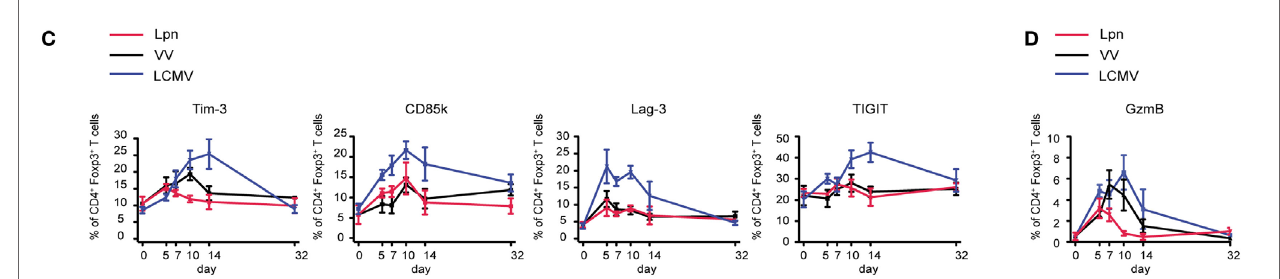
FigUre 4 | Expression of co-inhibitory receptors and granzymes is a mutual feature of Th1-driven Treg specialization. C57BL/6 mice were acutely infected with LCMV WE (blue), Legionella pneumophila (Lpn, red), Vaccinia Virus (VV, black), C. albicans (yellow), or left naïve and expression of the co-inhibitory receptors Tim-3, CD85k, Lag-3, and TIGIT (a,c) , or granzyme B (B,D) among live CD4 + Foxp3 + Treg cells was determined by flow cytometry. (a,B) Peak expression levels of (a) TIGIT, CD85k, Lag-3, Tim-3, and (B) granzyme B among splenic CD4 + Foxp3 + Treg cells (Lpn: day 5–7; VV: day 7–10; LCMV: day 10–14) or among CD4 + Foxp3 + Treg cells isolated from cervical LNs ( C. albicans , day 7). (c,D) Frequencies of CD4 + Foxp3 + Treg cells expressing the indicated markers over time or in naïve controls are depicted. Summary data (mean ± SD; biological replicates; LCMV, VV and Lpn n = 5; C.a n = 6; naïve spleen n = 10, naïve LN n = 3) and representative plots of > 3 (LCMV, VV) or two (Lpn, C. albicans ) independent experiments are shown (* p < 0.05, ** p < 0.01, *** p < 0.001) (Mann–Whitney